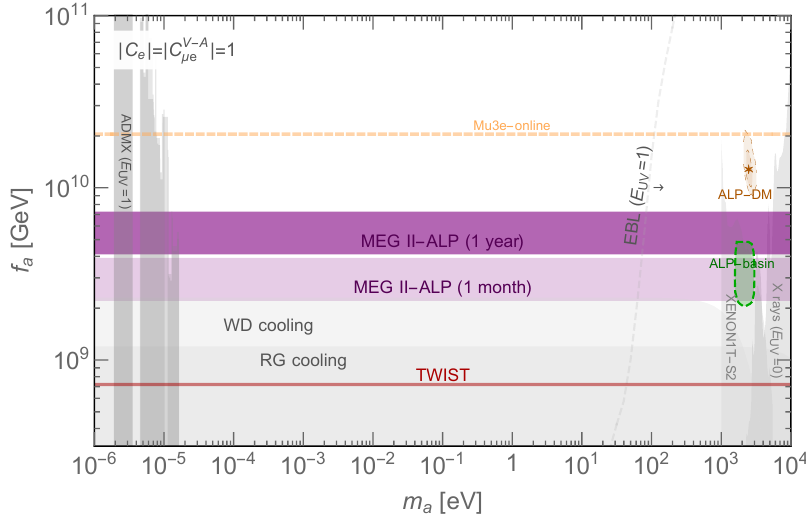
Figure 5 . ALP parameter space as a function of the decay constant f a and the mass m a , assuming C e = C V − A = 1 and E UV = 0 . The dark red line is the present TWIST bound [16], while the eµ purple bands correspond the projections for the MEG II-ALP dedicated run shown in figure 1. The solid/dashed line corresponds to 1 month/1 year of data taking. The dashed orange line shows the (speculative) projection for a Mu3e online analysis of µ + → e + a data [28]. The shaded grey regions show existing bounds from white dwarf (WD) and red giants (RG) cooling [29–31], X rays searches of γ lines from decaying DM [32, 33], absorption in direct detection experiments [34, 35], and existing resonant cavities [36–38] for E UV = 1 . The dashed grey line show the bound on decaying DM from diffuse extra-galactic light observations [39] if E UV = 1 (the arrow points towards the excluded region). In the dark orange blob ALP DM can explain the Xenon1T excess in